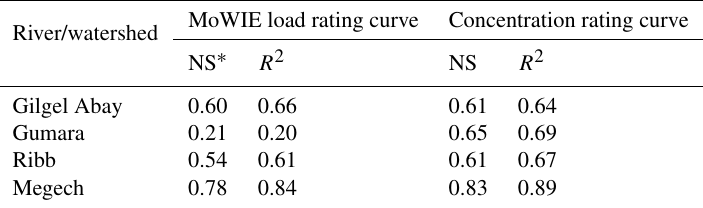
Table 4. Performance measures of sediment load predicted by MoWIE load rating curve and the concentration rating curve. MoWIE load rating curve Concentration rating River/watershed